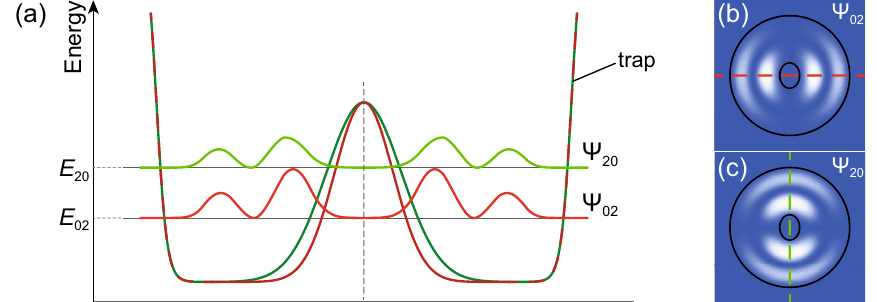
Figure 5. Schematic of the splitting of eigenmodes in a trap with a reduced symmetry. ( a ) The diagram shows the potential landscape of the trap, detailing the lifting of energy degeneracy of the 3 p -like modes. ( b , c ) Color maps showing 3 p -like polariton condensate modes, (cid:31) 02 and (cid:31) 20 , in the trap. The trap is formed by the stationary potential of the micropillar (outer edge) and by the cloud of excitons under the pump spot near the center of the micropillar (central peak). The symmetry of the trap ring is reduced due to the elliptical shape of its central peak. Black contours on pales ( b , c ) give a hint about the shape of the trap. Dark green (red) curve in panel ( a ) shows cross section of the trapping potential along the long (short) axis of the ellipse of the central peak. Light green (red) curve in ( a ) shows cross section of the polariton condensate eigenmode (cid:31) 20 ( (cid:31) 02 ) quantized along the direction coinciding with the long (short) axis of the ellipse. The corresponding cross sections are indicated by red and green dashed lines in panels ( b ) and ( c ).